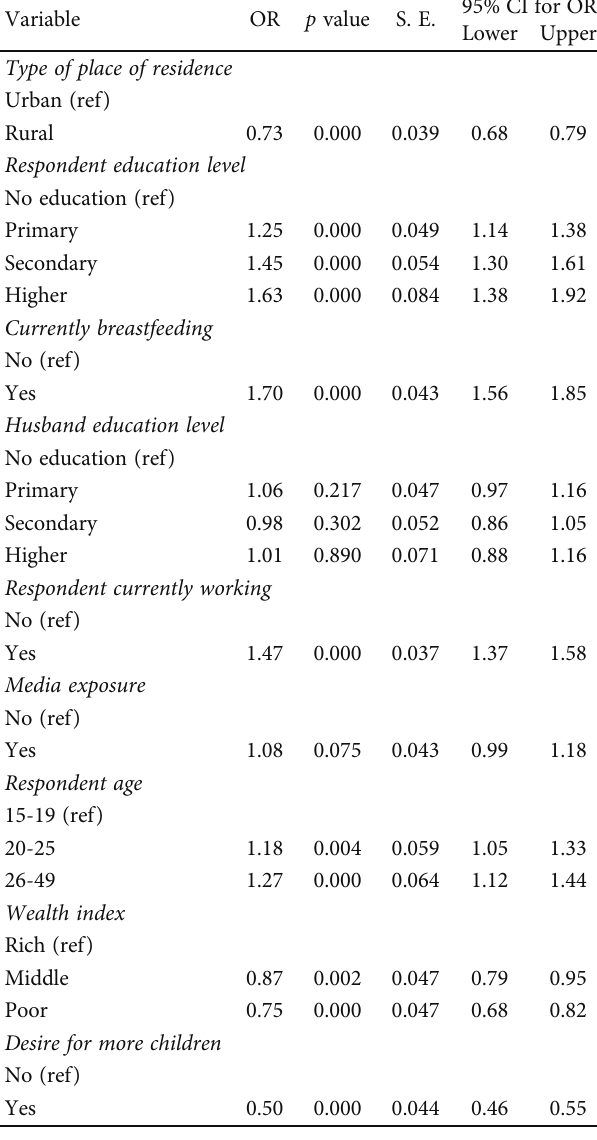
Table 2: Binary logistic regression model estimation for Bangladesh for di ff erent in fl uencing factors of contraceptive